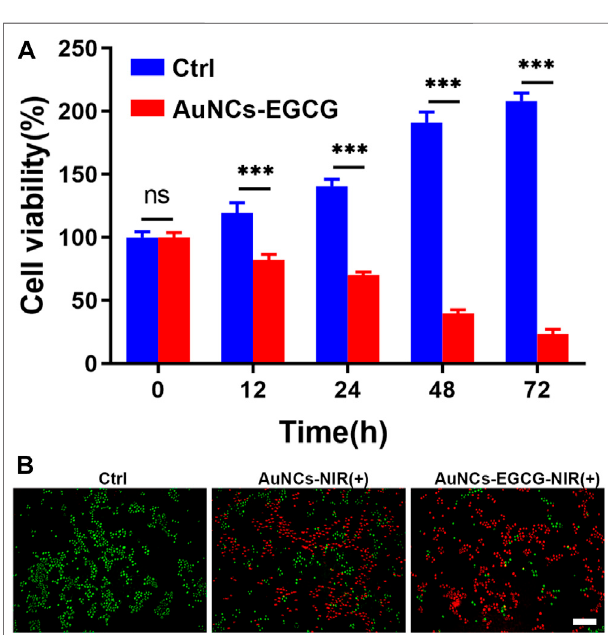
FIGURE 4 | NIR-responsive AuNCs-EGCG inhibited proliferation of HepG2cells. (A) EffectsofNIR-responsiveAuNCs-EGCGatdifferenttimeson the proliferation of HepG2 cells observed by MTT method. The mean and standarddeviation(SD)ofthedata( n =3)areshown.Statisticalanalysis: ppp p < 0.001. (B) Fluorescent images of Live/Dead-stained HepG2 cells after different treatments. Green: live cell staining, Red: dead cell staining. Scale bars are 25 μ